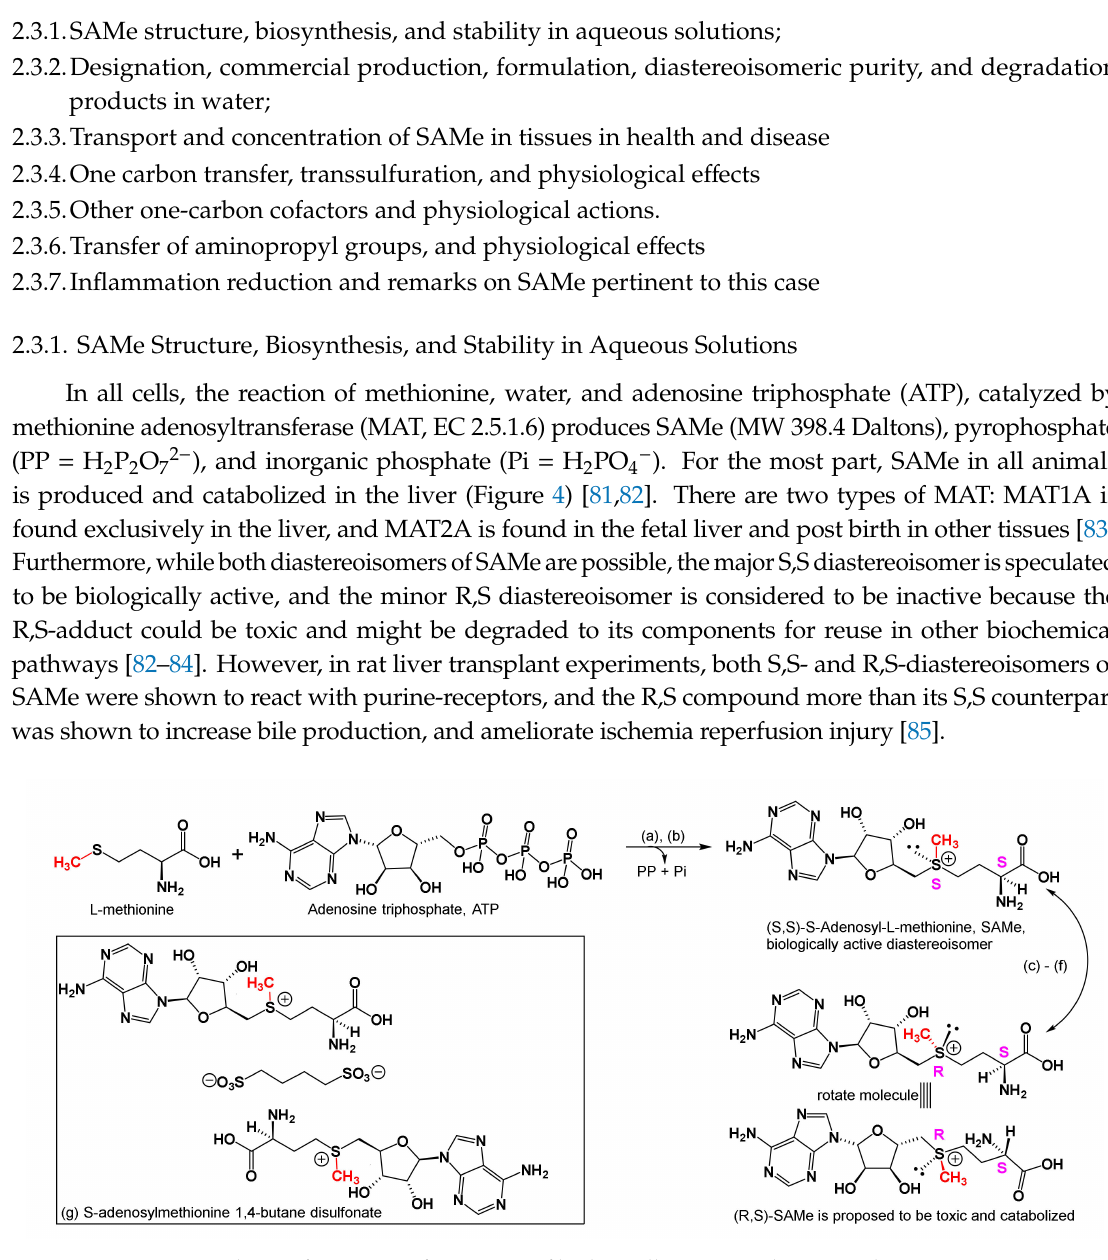
Figure 4. Biosynthesis of SAMe, configurations of biologically active and inactive diastereoisomers, its relative concentrations in serum, and CSF, and a cartoon of the commercial SAMe 1,4-butane disulfonate formulation. ( a ) In all cells, the reaction of ATP, water, and methionine, catalyzed by ATP:methionine adenosyltransferase, MAT, EC 2.5.1.6, is proposed to provide only the S,S-diastereoisomer of SAMe, MW = 398.4 Daltons, plus pyrophosphate, PP ( = H 2 P 2 O 72 − ), and inorganic phosphate, (Pi = H 2 PO 4 −